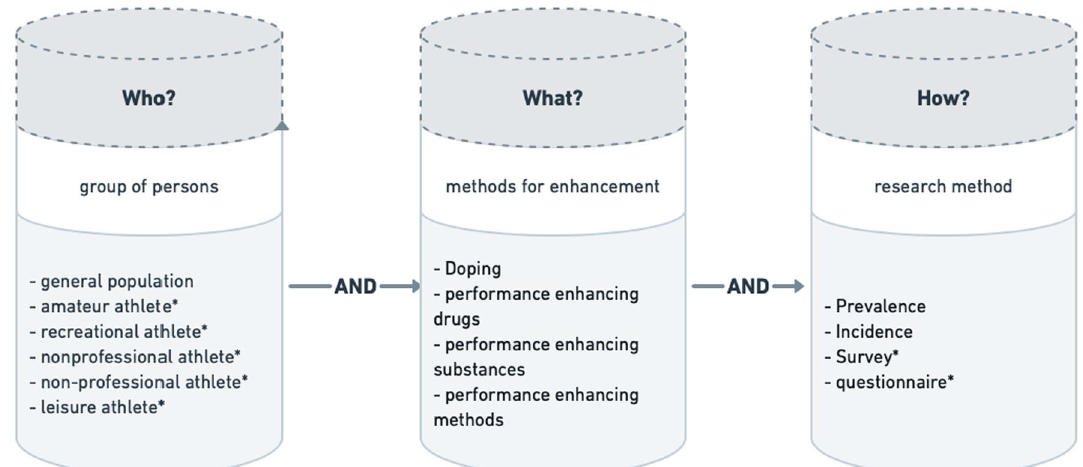
Fig. 1 Literature search procedure. Combinations of terms were used for the search process in the literature review. Categories were linked with AND while search terms within the categories were linked with OR. The term combinations are made up of Who? (target group of the study), What? (used substances in a study), and How? (used method of the study). The respective terms of the category are listed in each case as example terms in the